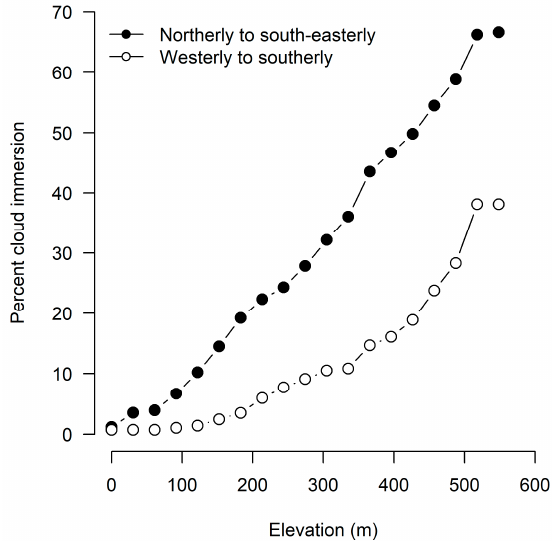
Figure 6. Percent of observations in which given elevations on the Mt Honey transect, Perseverance Harbour, Campbell Island were within the cloud base. A total of 576 twice daily (09:00 and 16:00 h) observations of cloud base were made from 1 March to 3 October 1991. Winds from northerly to south-easterly quarter (solid line) bring much lower cloud bases than those from westerly to southerly quarter (broken line). From Reference [10].